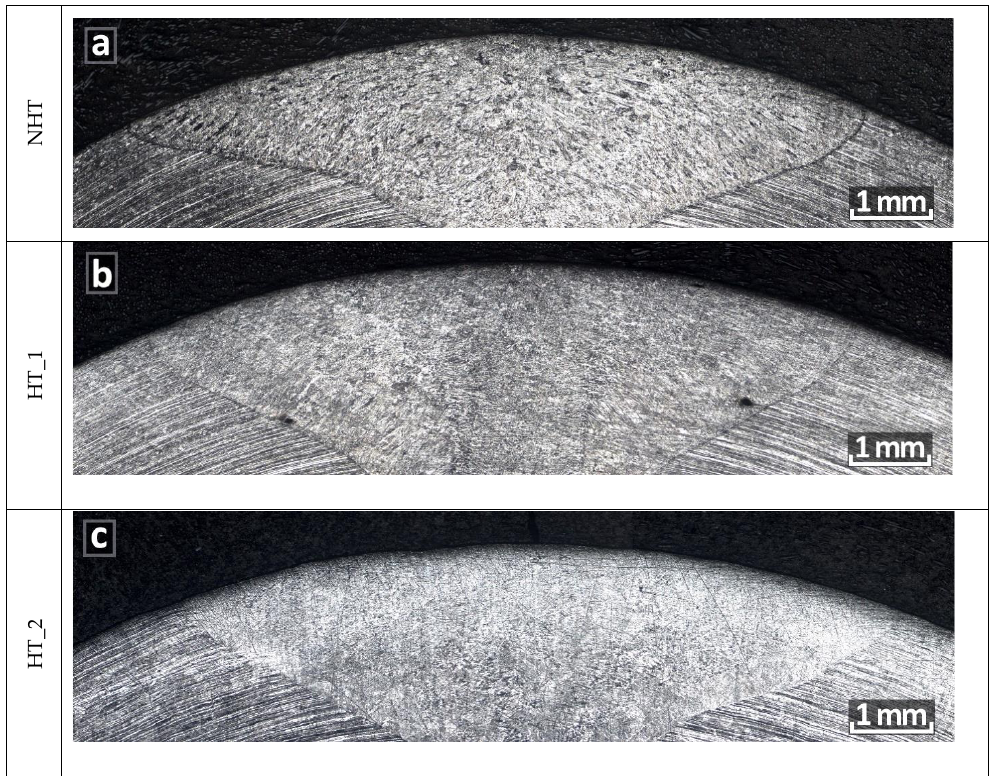
Figure 11. Transverse sections after intergranular corrosion testing (IGC) testing and three point bend test ( a ) NHT sample; ( b ) HT_1 sample; ( c ) HT_2 sample.